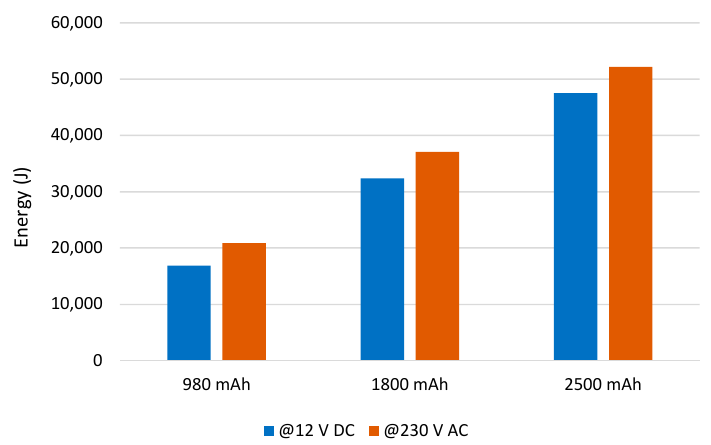
Figure 8. Power consumption in charging a lithium battery.